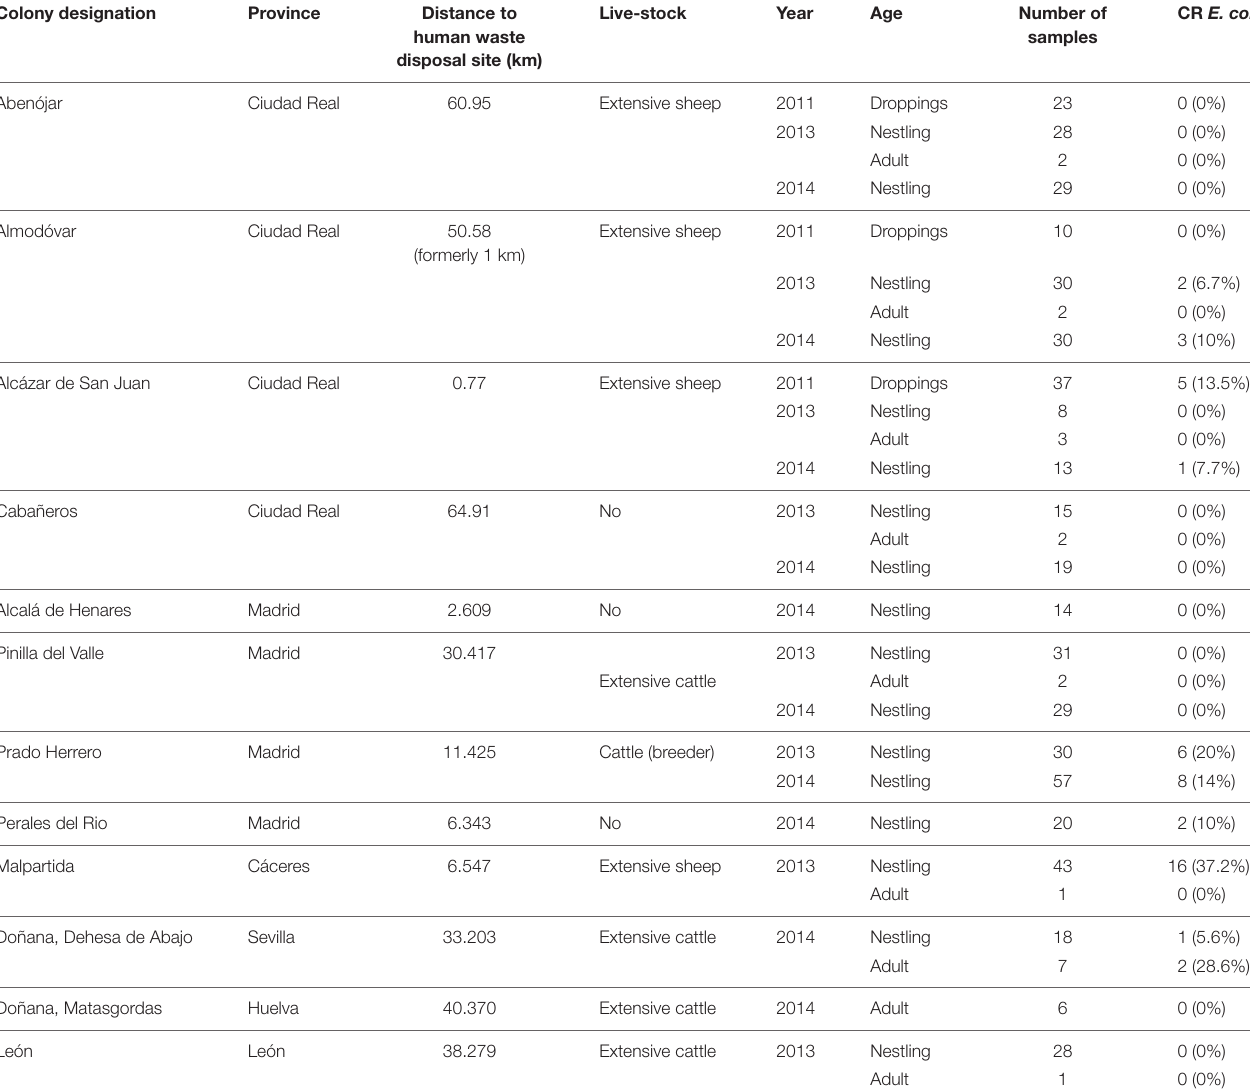
TABLE 1 | Location, distance to closest human waste disposal site, presence of livestock, and type, and number of samples and presence of CR E. coli obtained from the different white stork colonies. Colony